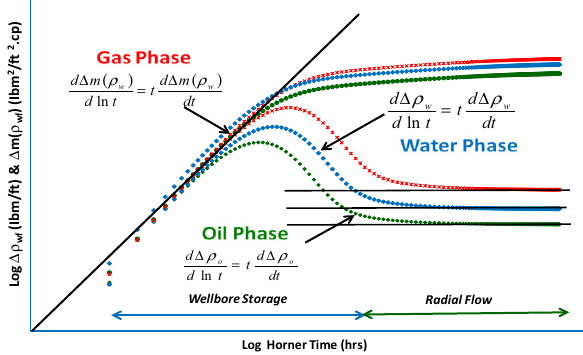
Fig. 3 Diagnostic log–log plots of fluid densities (gas, oil and water) derivatives versus time